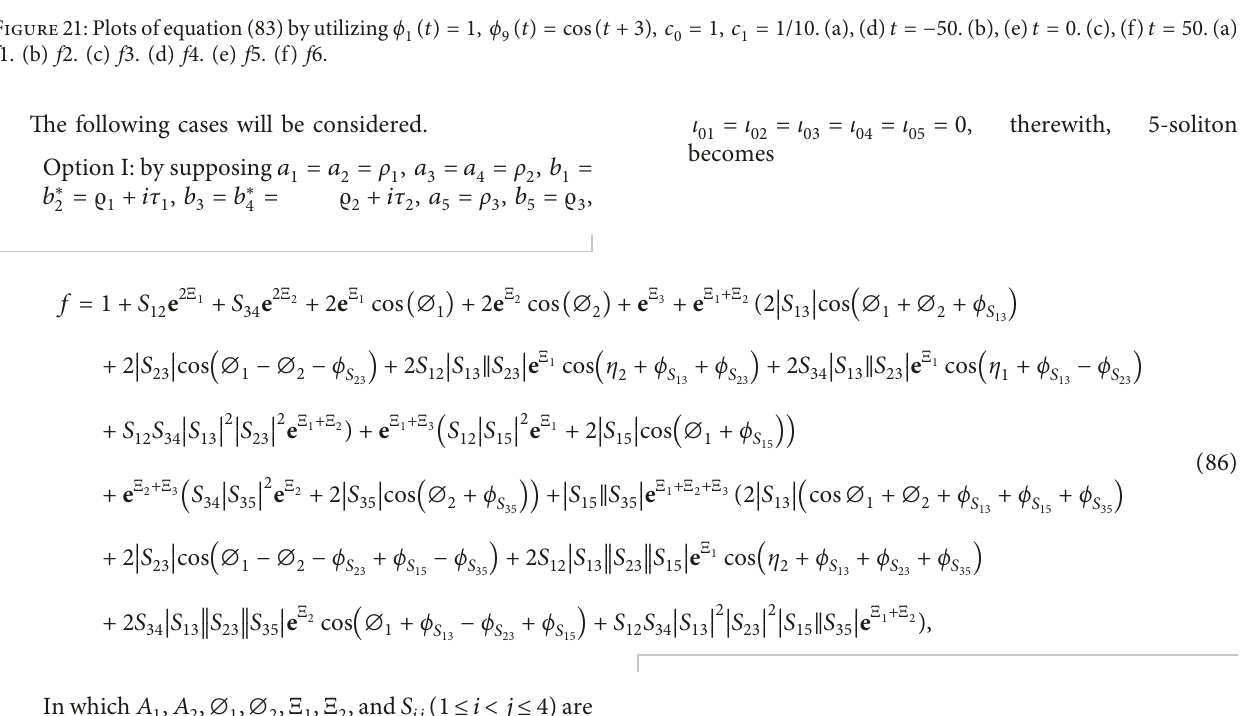
� 1 , c � 1/10. (a), (d) t � − 50. (b), (e) t � 0. (c), (f) t � 50. (a) 0 1